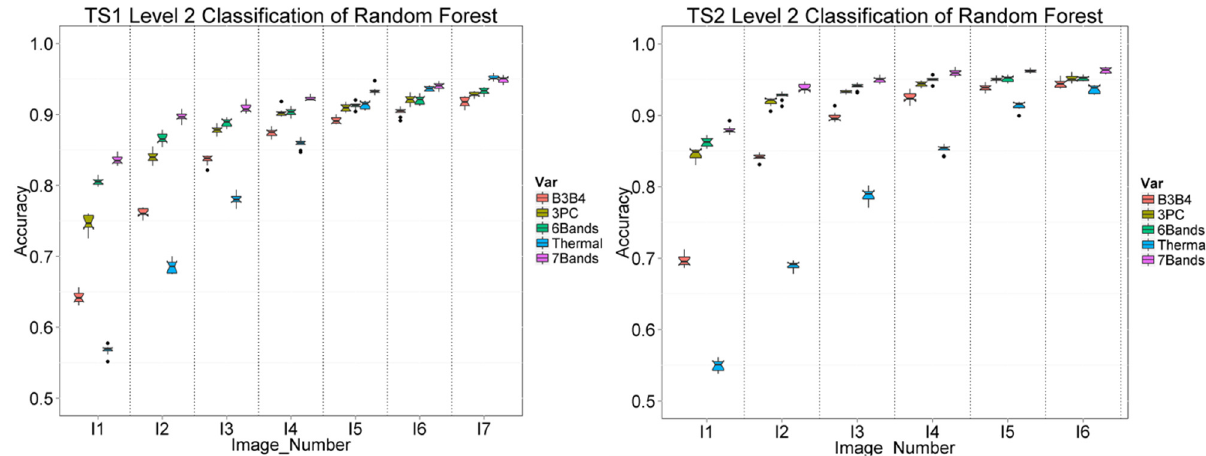
Figure 7. TS1 and TS2 boxplot of the 10-fold Level 2 classification overall accuracy variation by Random Forest for time series images of the combination of band 3 and band 4 (B3B4), the first three principal components (3PC), the combination of 6 bands (6Bands), the thermal bands and the combination of 7 bands